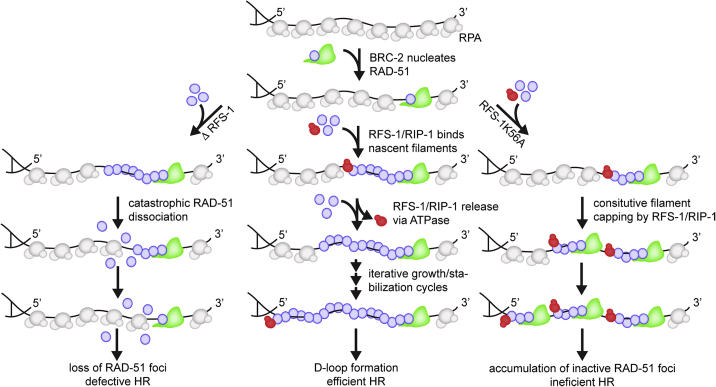
Model describing the mechanism of metazoan RAD-51 presynaptic filament assemblyBRC-2 nucleates RAD-51 on RPA-coated resected ssDNA. Nascent RAD-51 filaments are bound at 5′ end by RFS-1/RIP-1, which stabilizes growing RAD-51 filaments preventing burst-like disassembly from filament ends. ATPase-mediated dissociation of RFS-1/RIP-1 allows for further recruitment of RAD-51 protomers allowing filament growth in 5′ direction. Inability of RFS-1 K56A/RIP-1 to dissociate from bound RAD-51 filaments results in extensive end capping and formation of very stable, shorter, less-active RAD-51 filaments, which accumulate by the action of BRC-2-mediated RAD-51 nucleation.